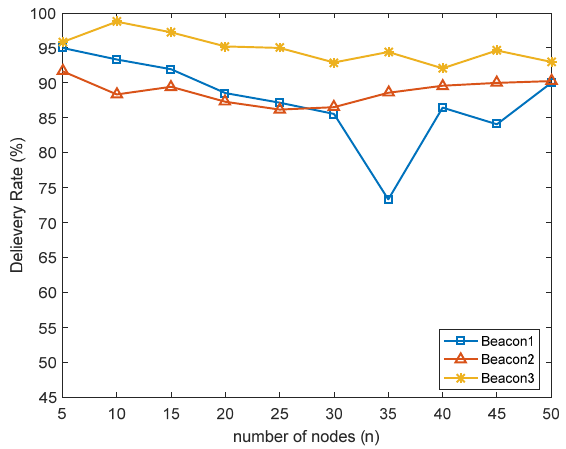
Figure 7. Delivery ratios of beacon routing protocol at different inbound times.